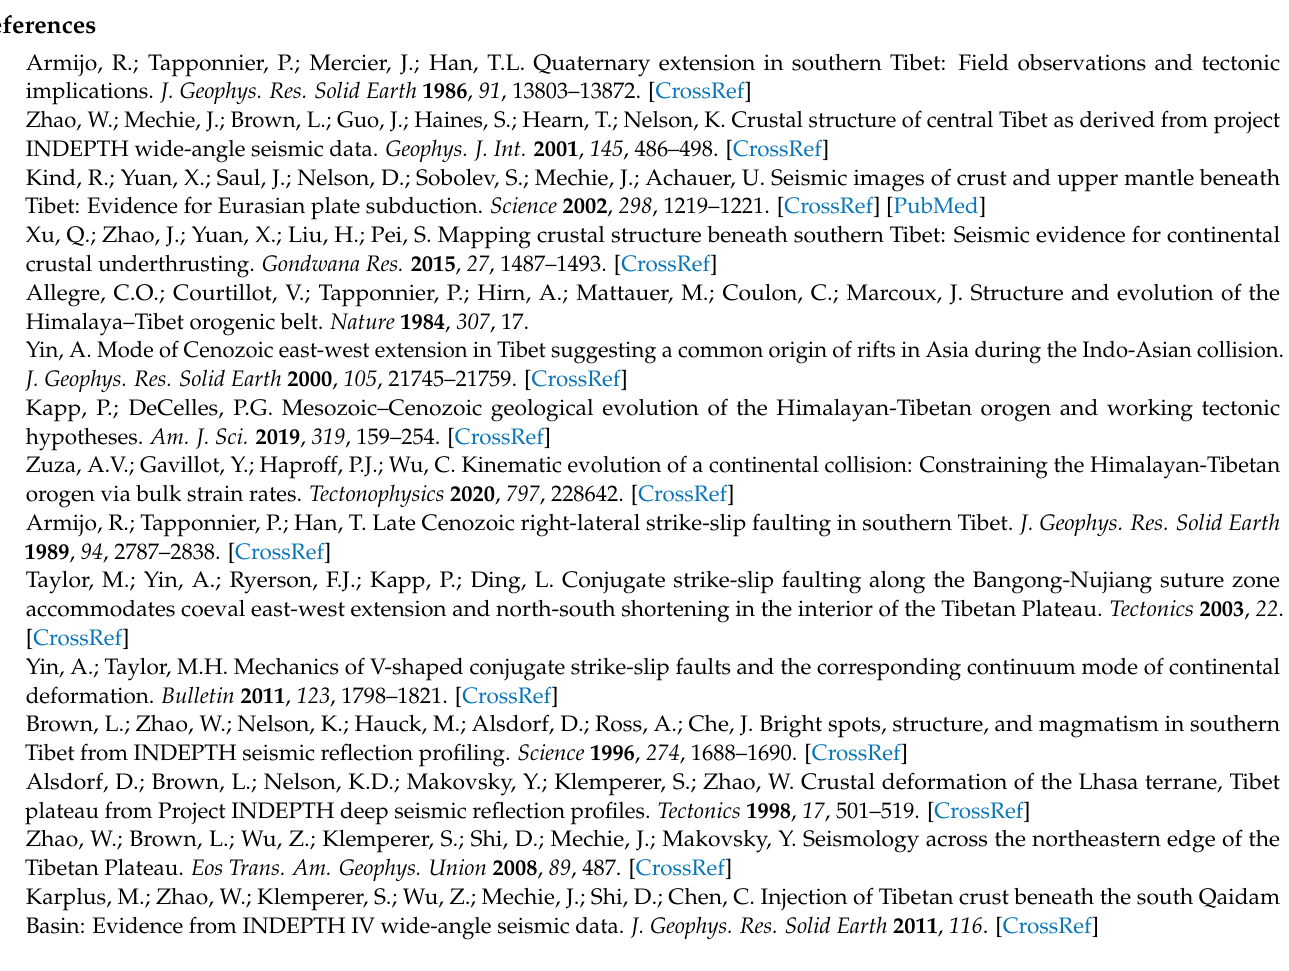
Table S2: Lu-Hf Isotope Geochemistry Data, Supplementary Table S3: T/REE Geochemistry Data, Supplementary Table S4: ZHe Thermochronology Data, Supplementary Table S5: HeFTy Thermal Modeling Parameters, Figure S1: U-Pb Geochronology Concordia Plots, Figure S2: La/Yb Crustal Thickness